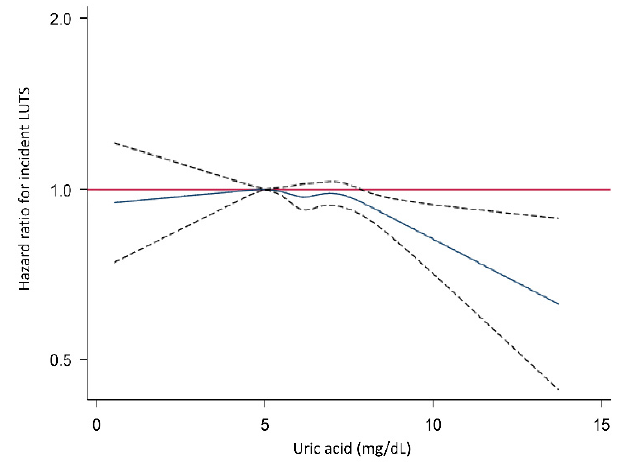
Figure 1. The relationship between serum uric acid levels and the incidence of significant LUTS. Curves were estimated from a Cox proportional hazards regression model representing the relation- ship between serum uric acid levels and incidence of significant LUTS. Broken lines represent 95% confidence intervals. LUTS, lower urinary tract symptoms.